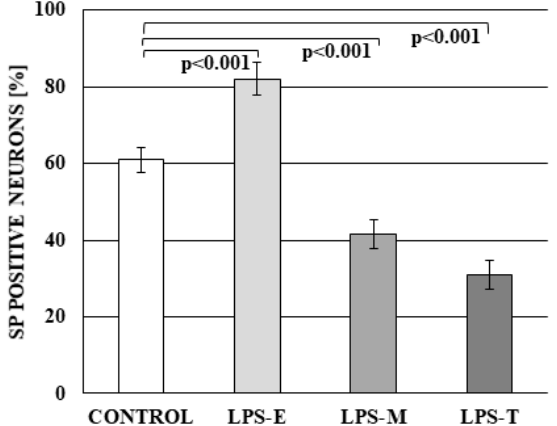
Figure 3. The percentage of neurons in dorsal root ganglia (DRG) immunoreactive to substance P (SP) in the control group and under the impact of LPS from S. Enteritidis (LPS-E), S. Minnesota (LPS-M), and S. Typhimurium (LPS-T). Statistically different at p < 0.001 as compared to the control group.